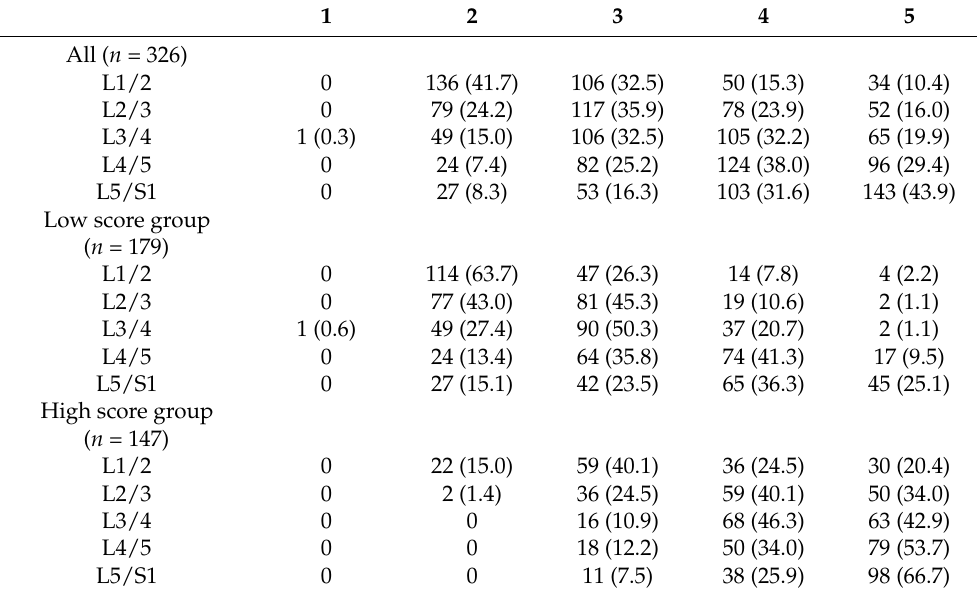
Table 2. The Pfirrmann grading system for lumbar disc degeneration.